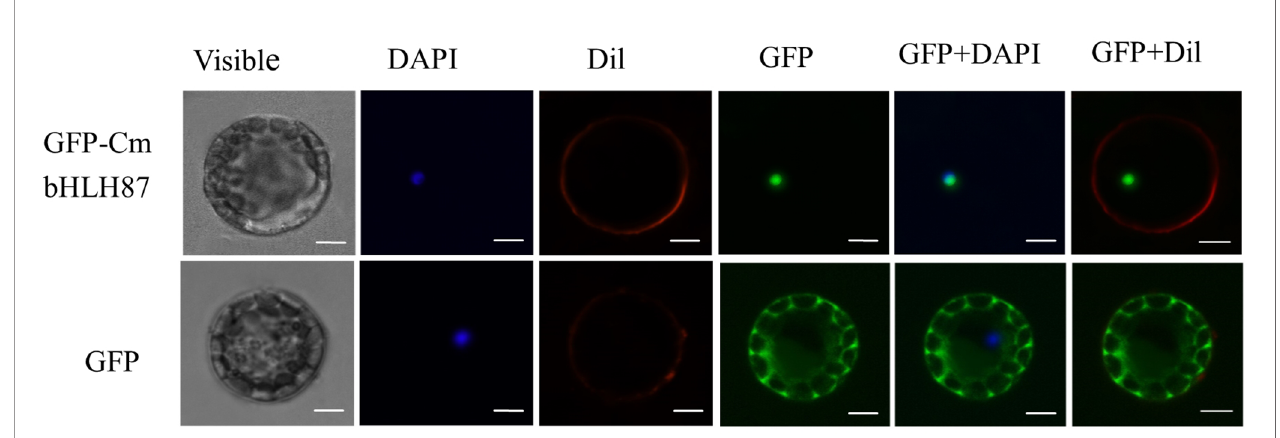
FIGURE 1 | The subcellular localization of pumpkin CmbHLH87. The fused green fl uorescent protein (GFP) – CmbHLH87 and alone GFP constructs were introduced into Arabidopsis protoplast by polyethylene glycol-mediated protoplast transformation. The fl uorescent signals were detected using a confocal fl uorescence microscope. Scale bars = 5 m